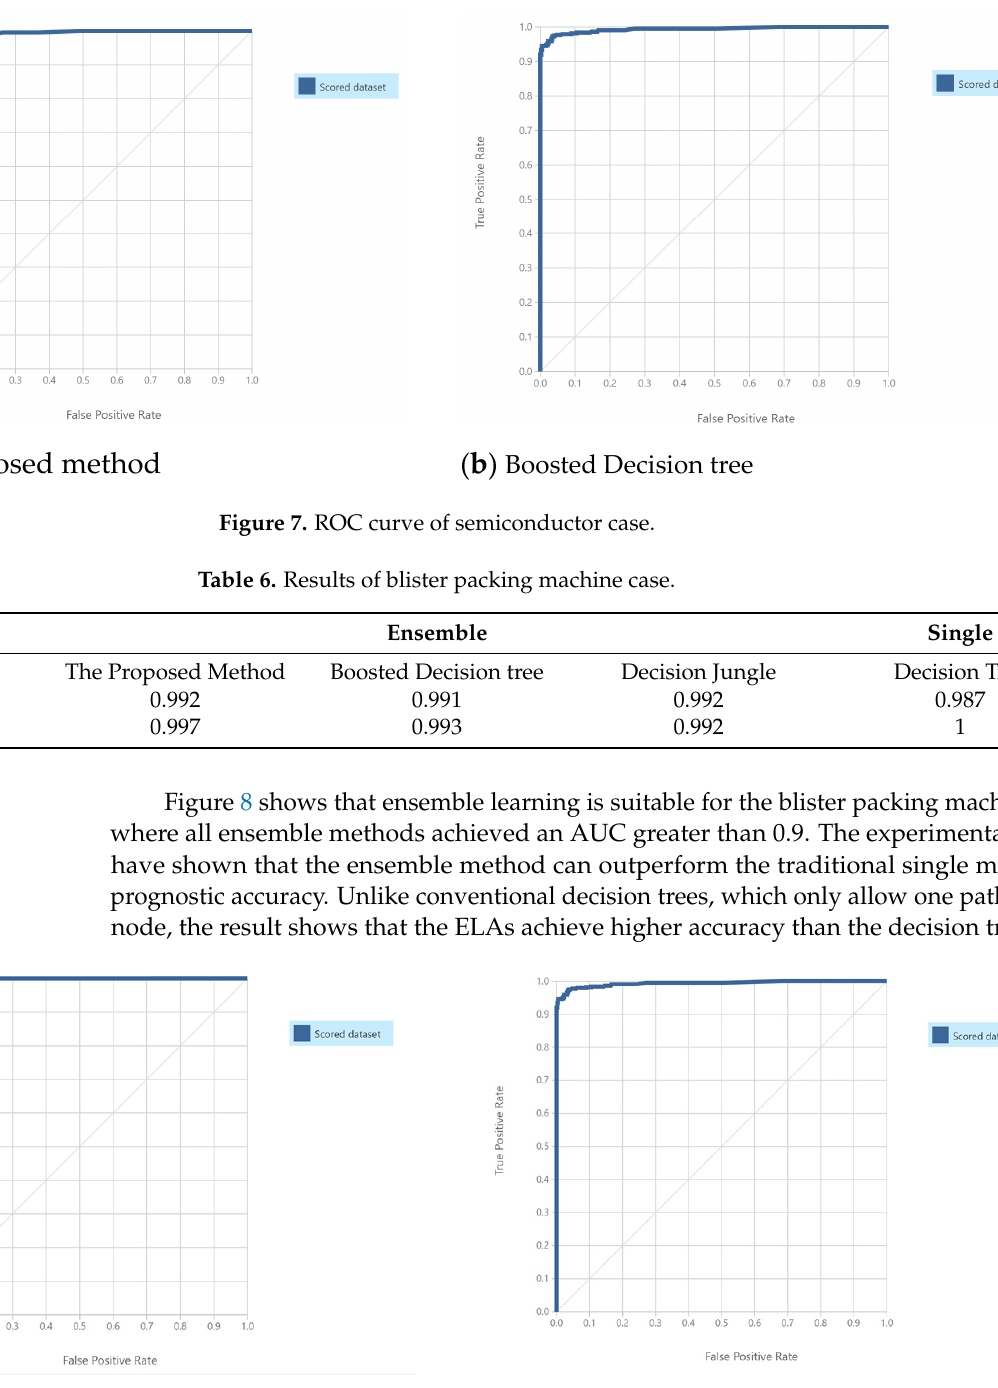
Figure 7. ROC curve of semiconductor case.